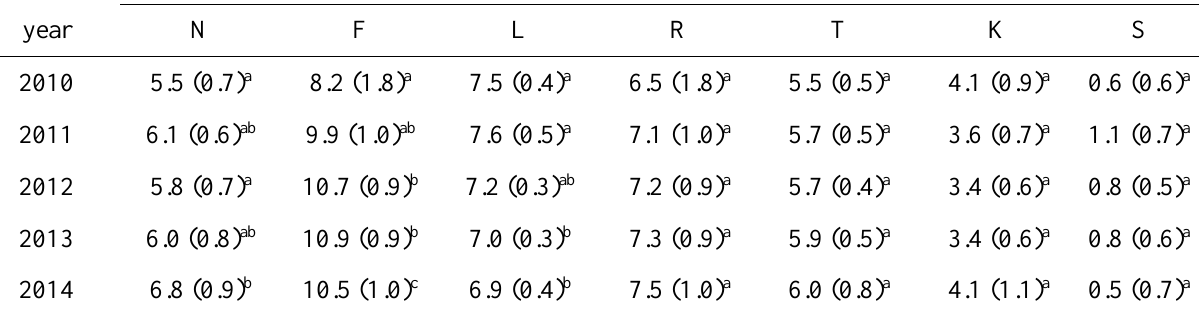
Table 2. Community weighted mean Ellenberg indicator values throughout the site (standard deviation in brackets) in the course of the years. Significance of differences tested with t-test. Both imply the assumption of the indicator values being metrically